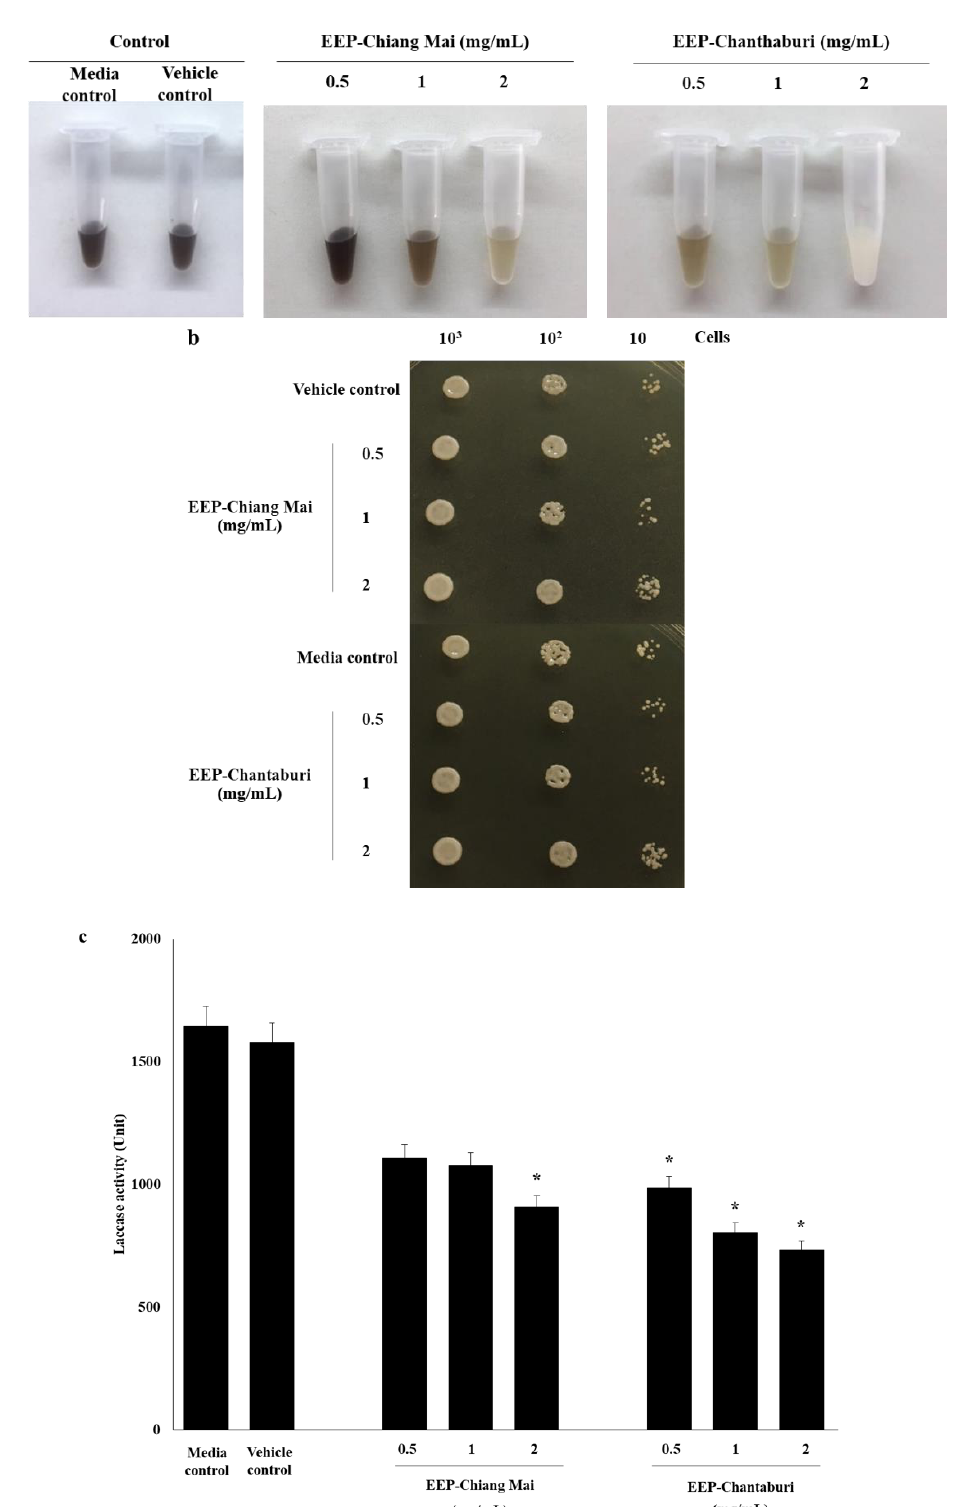
Figure 3. Anti-melanization of EEP-treated C. neoformans . ( a ) Melanization of C. neoformans in the presence of L-DOPA at various concentrations of EEP for 5 days of incubation. ( b ) Colony-forming units (CFU) of EEP-treated C. neoformans on SDA. ( c ) Laccase activity was investigated after the EEP treatment. The results are expressed as mean ± SEM of three independent experiments in duplicate. Significant di ff erences (* p < 0.05) when compared with the vehicle control were determined by one-way ANOVA.